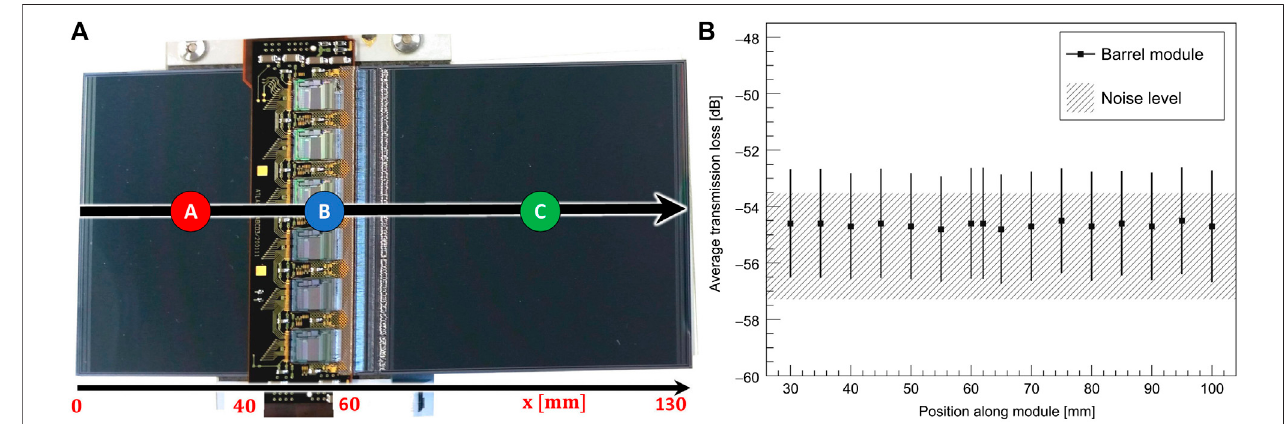
FIGURE 4 | (A) The ATLAS SCT barrel module under test. Positions for frequency scans are denoted by (A) , (B) and (C) . A position scan is performed along the blackarrow. (B) Transmissionlossofthebarrelmoduleaveragedoverthefrequencybandforapositionscan(alongthearrowinpanel4A)andthenoiselimitedsensitivity of the spectrum analyzer. The uncertainties represent the RMS of the average measurements [26].